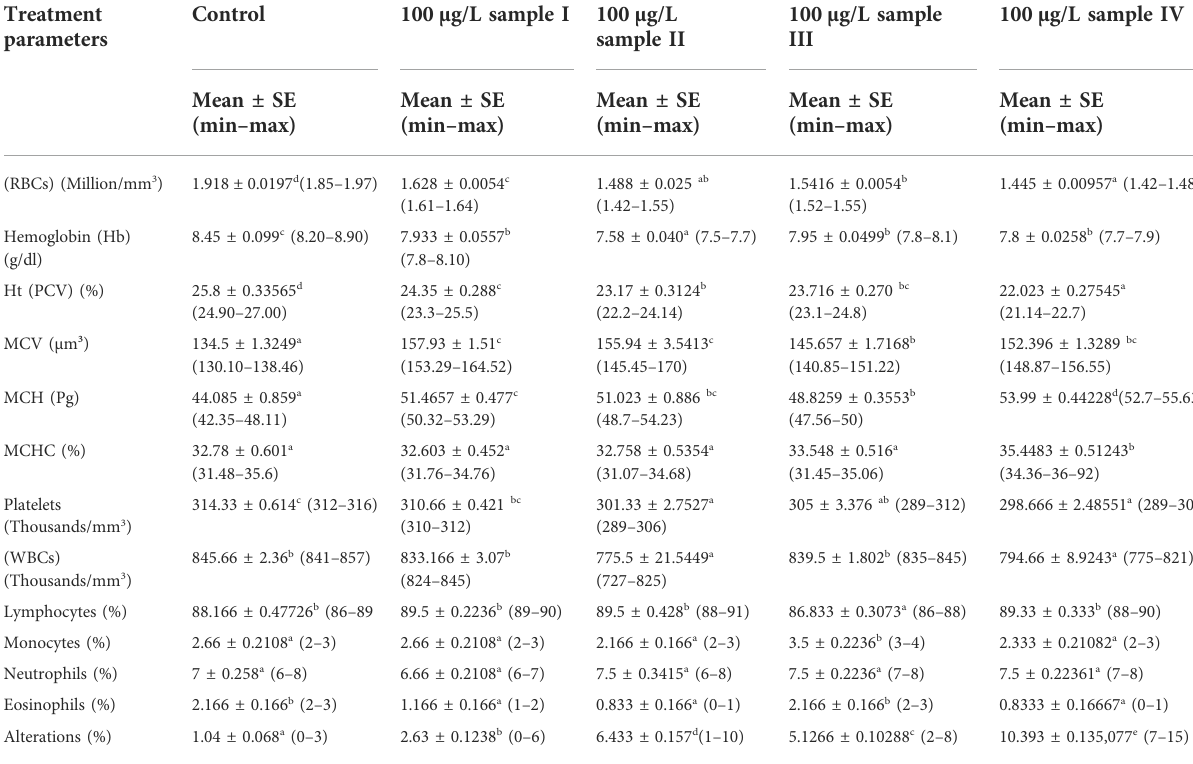
TABLE 2 Effect of alkaline rock powder exposure for 15 days on the hematological parameters of juveniles of Tilapia ( Oreochromis niloticus ). Treatment